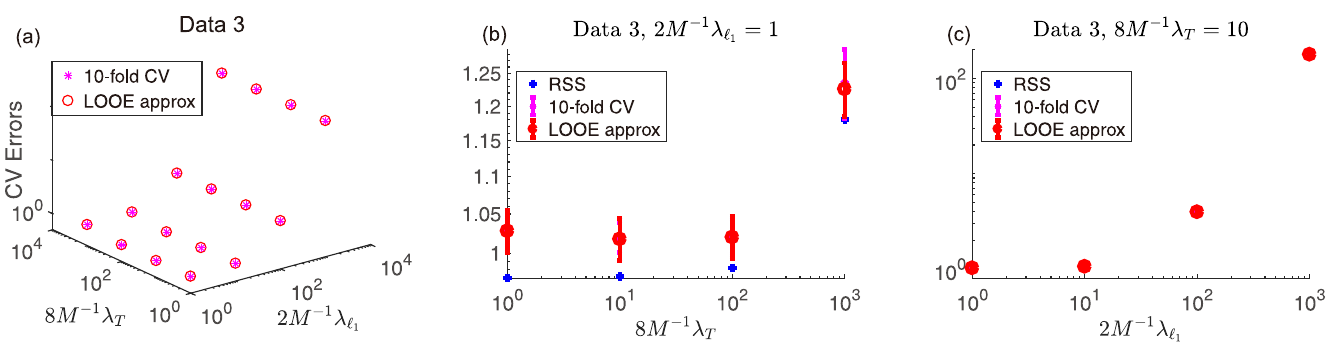
Fig 2. (a) 3D plot of mean CVEs against λ ℓ and λ T without error bars. (b) Plot of mean CVEs and RSS against λ T at the optimalvalue of λ ℓ 1 Plot of mean CVEs and RSS against λ ℓ at the optimalvalue of λ T , 8 λ T / M = 10. For (c), the RSS is overlappedwith the CVEs in the symbol size. In all the 1 cases, the agreementbetween the approximate LOOE and the 10-fold CVE is fairly good. The tuning constants δ and θ are set to be δ = 10 − 4 and θ = 10 − 12 , respectively.